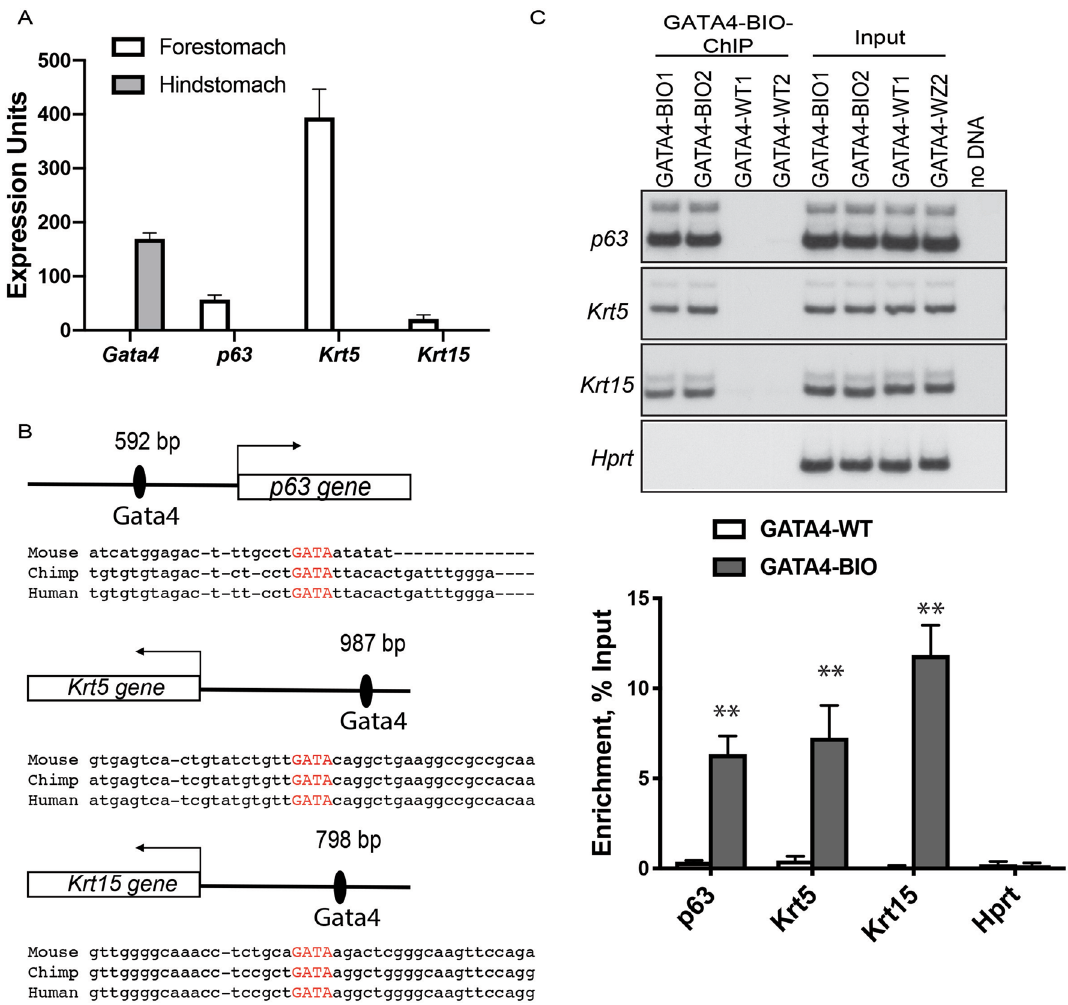
Figure 5. GATA4 occupies the proximal promoters of squamous epithelial cell marker genes suggesting that GATA4 can repress expression of these genes. ( A ) qRT-PCR was used to examine the expression profiles of Gata4 , p63 , Krt5 , and Krt15 genes in mouse columnar, glandular hindstomach and stratified squamous forestomach epithelial cells. As expected, Gata4 transcript was detected only in columnar hindstomach epithelium, whereas p63 , Krt5 , and Krt15 transcripts were detected only in the stratified squamous forestomach. ( B ) Diagrammatic representation of GATA consensus binding sites identified as evolutionarily conserved among human, mouse, and chimpanzee in the p63 , Krt5 , and Krt15 genes. ( C ) GATA4 Bio-ChIP–PCR showed enriched amplification of regions containing predicted evolutionarily conserved GATA binding sites in the p63 , Krt5 , and Krt15 genes in cells expressing biotinylated GATA4 compared with control cells lacking biotinylated GATA4. No amplification enrichment was observed for a gene lacking a GATA4 binding site (Hprt ). Autoradiographic band intensity was measured using a Storm820 Phosphor Imager and ImageQuant software. Representative autoradiographic data for two of four animals per genotype assayed shown. Amplification enrichment per sample was normalized to input (n = 4 GATA4-BIO and 4 GATA4-WT). Error bars show SEM, ** P ≤ 0.01. The full autoradiograph used to generate panels is shown in Supplementary Fig. samples (n = 9) examined or regions of normal squamous esophageal epithelium within BE or EAC samples expressed GATA4 (Fig. 6). Acid and bile induce GATA4 expression in human squamous cells.